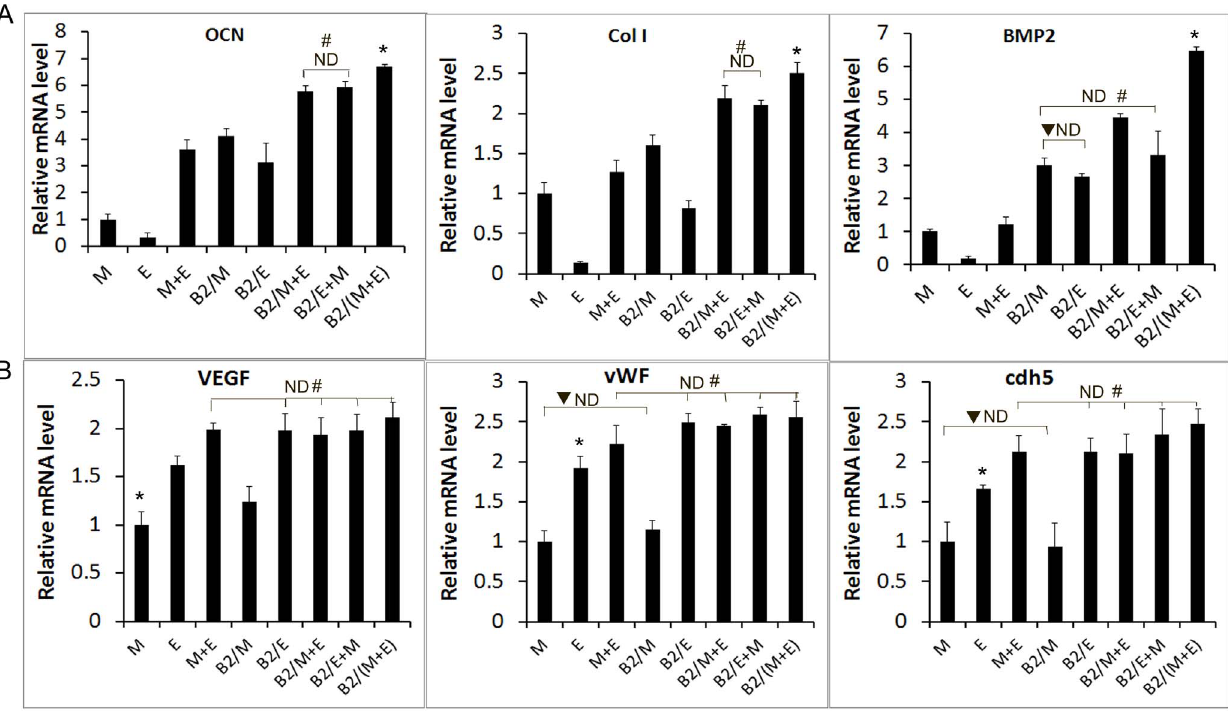
Figure 3. qRT-PCR analysis of osteoblast and endothelial marker genes. MSCs, EPCs or MSCs and EPCs with or without BMP2 gene modification (1:1) were plated in 24-well plate as a density of 2.25 6 10 4 cells/cm 2 as described in Materials and Methods . These groups were MSCs alone (M), EPCs alone (E), MSCs + EPCs (M + E), BMP2 gene-modified MSCs (B2/M), BMP2 gene-modified EPCs (B2/E), EPC + BMP2 gene-modified MSCs (B2/M + E), MSC + BMP2 gene-modified EPCs (B2/E + M), and BMP2 gene-modified MSCs + BMP2 gene-modified EPCs (B2/(M + E)). The cells were induced with EGM/OS media for 14 days for qRT-PCR analysis. Data represent the mean + SD of n =6 samples. (A) Osteoblast marker genes: OCN, Col I and BMP2. (B) Endothelial cell marker genes: VEGF, cdh5 and vWF. For A and B, ND: p . 0.05, there is no significant difference between any two groups among the indicated ND groups. * p , 0.05: between any two groups except the ND groups. # p , 0.05: any ND groups vs. any other groups. . p , 0.05, any group in ND groups vs. any other groups.